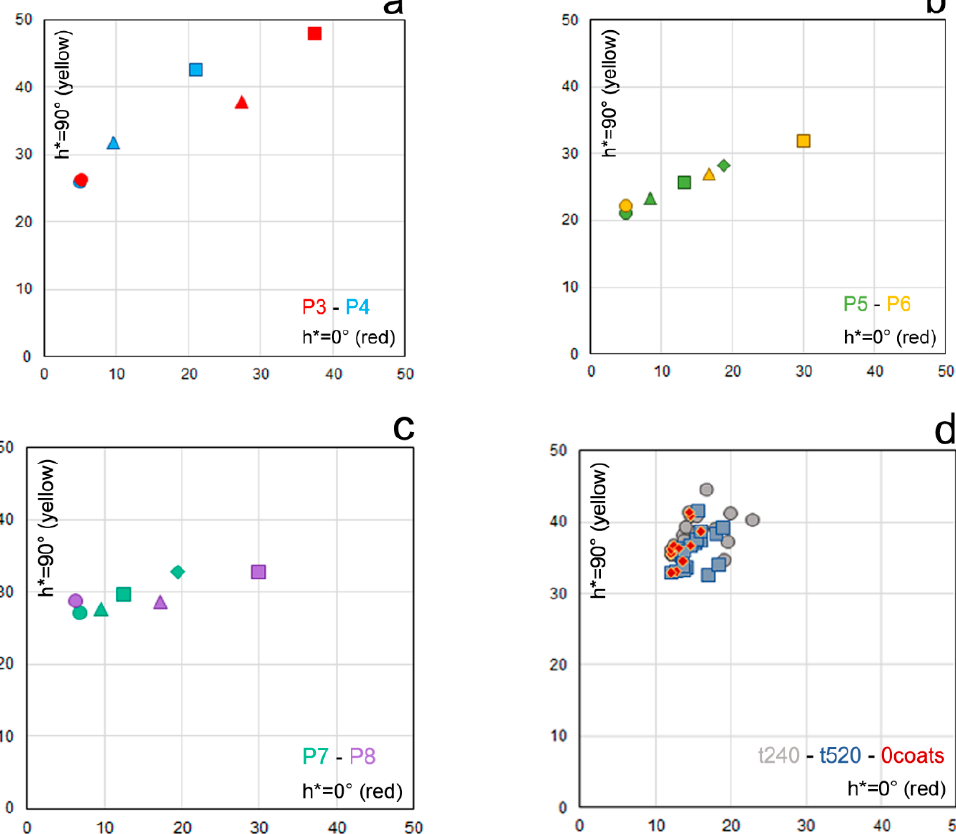
Figure 4. Colour coordinates in the C * h * plane (polar reference system): Unaged samples of ( a ) P3 and P4, ( b ) P5 and P6, and ( c ) P7 and P8. Circles refer to uncoloured coating systems, triangles to 1 coat, squares to 2 coats and diamonds to 3 coats. ( d ) Aged samples; circles refer to t = 240 h, squares to t = 520 h, red marks are referred to aged uncoloured samples.